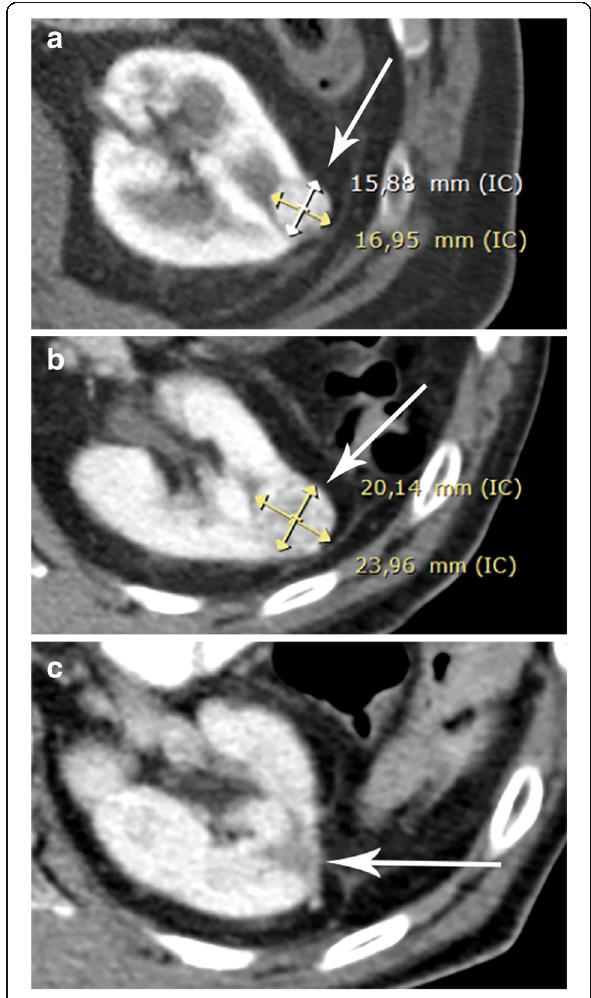
Fig. 10 Linear GR calculation of a SRM in AS in a 73-year-old patient. a Contrast-enhanced CT of a renal mass (arrow) with a MTD of 1.7 cm (16.95 mm) at the beginning of AS and ( b ) 3 months later (arrow), showing a MTD of 2.4 cm (23.96 mm). Using the linear GR formula, the difference of MTD (2.4 cm − 1.7 cm = 0.7 cm) is divided by the time between the two CT scans (3 months), and the result (0.3 cm) is multiplied by 12, resulting in 2.6 cm. c Taking into account that the mass presented a GR of more than 0.5 cm/year,